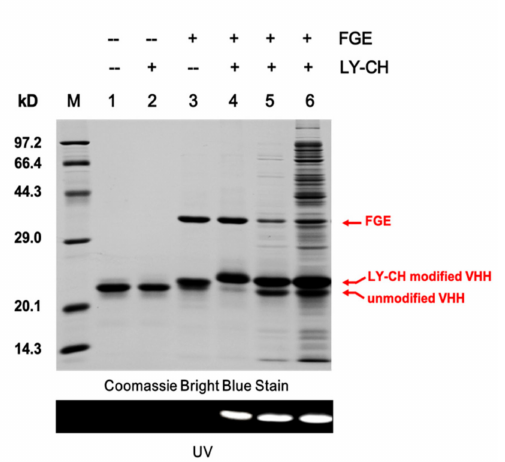
Figure 2. Validation of the site-specific modification of VHHs. SDS-PAGE analysis of Aldtag-VHH and the lucifer yellow CH (LY-CH) labeled products. Lane M, molecular weight markers; lane 1, native Aldtag-VHH; lane 2, Aldtag-VHH incubated with LY-CH; lane 3, FGE modified Aldtag-VHH incubated without LY-CH; lane 4, FGE modified Aldtag-VHH incubated with LY-CH; lane 5, crude cell extract was pretreated with 50% acetic acid to pH 4 with adjustment to pH 9 with 1 M NaOH; lane 6, crude cell extract pretreated with 1 M NaOH (adjusted directly to pH 9).